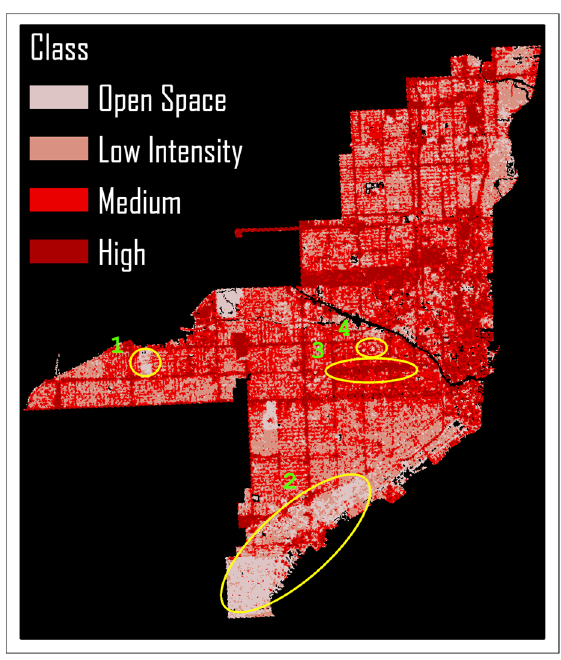
Figure 3 . USGS NLCD 2016 urban intensities with noticeable errors denoted. Figure 3. USGS NLCD 2016 urban intensities with noticeable errors